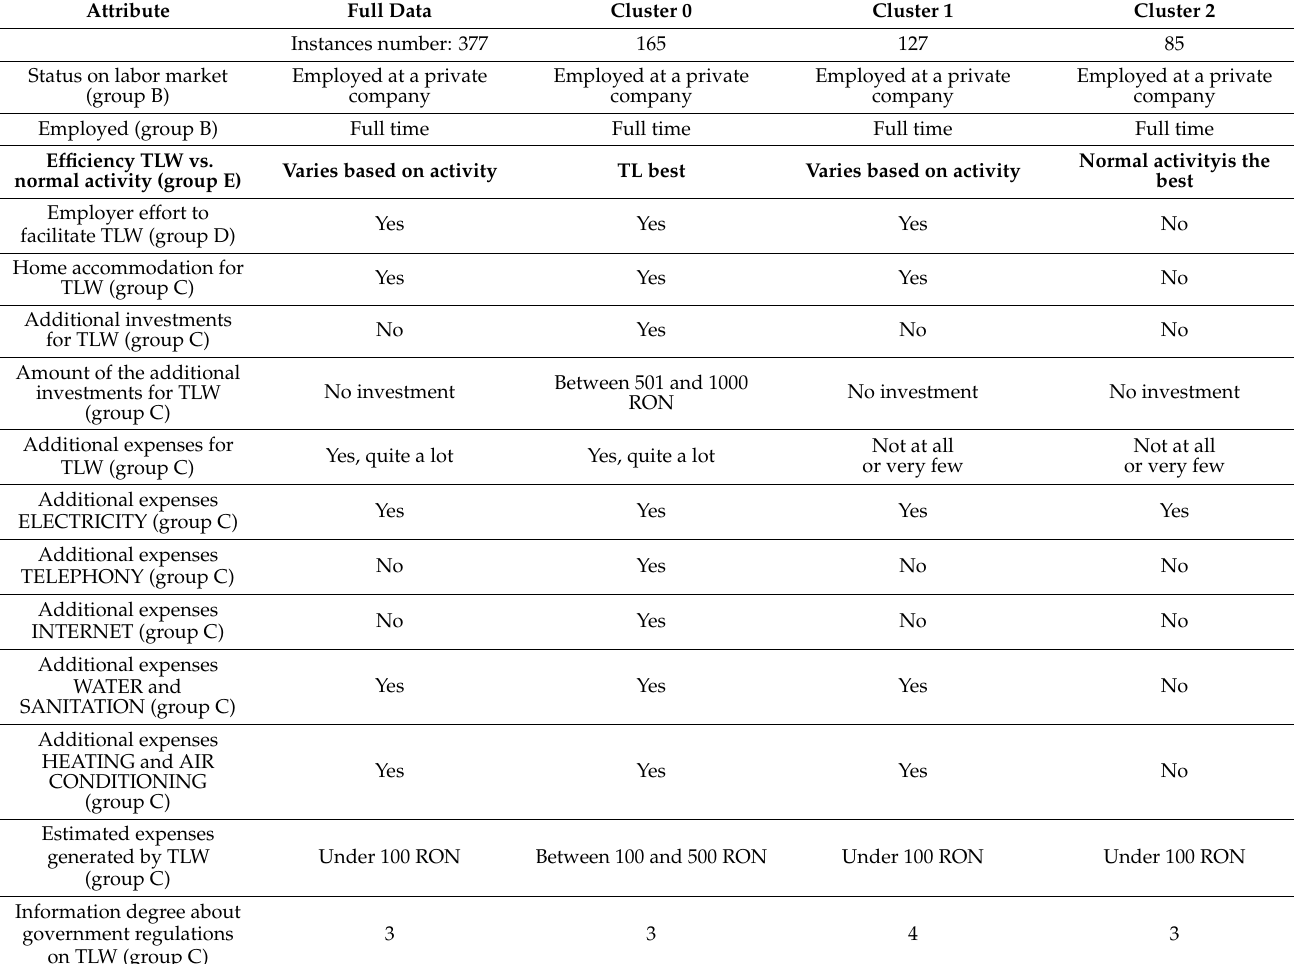
Table 3. Table 3. Cluster analysis of work